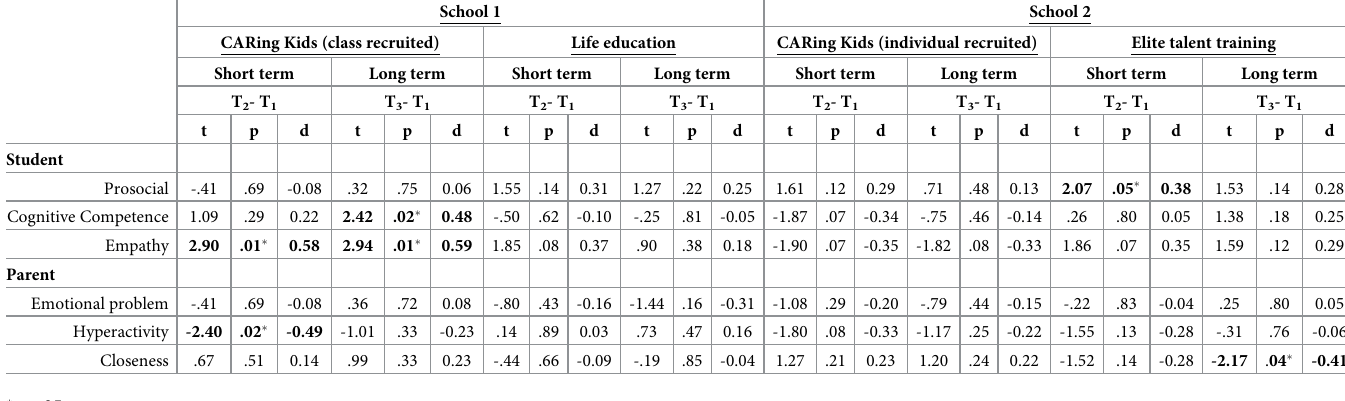
Table 3. Paired sample t tests for the short-term and long-term impacts among different interventions.